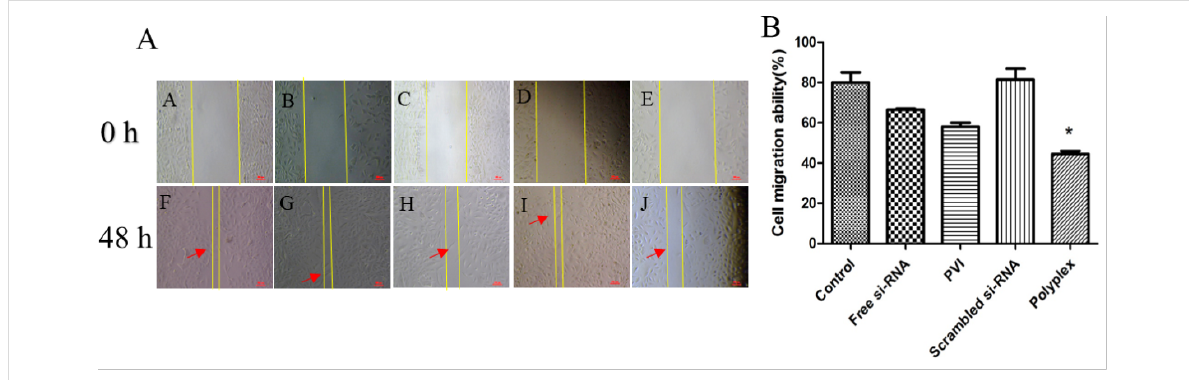
Figure 10: (A) Migration of A549 cells 48 h after treatment with free siRNA, blank polymer nanoparticles, polyplex with scrambled siRNA, and poly- plex with VEGF siRNA. VEGF silencing slows down the migration of A549 cells. Cells were exposed to the anti-VEGF siRNA for 4 h. (B) Migration rate of the A549 cells 48 h after treatment, n = 3, * p < 0.05 vs control.